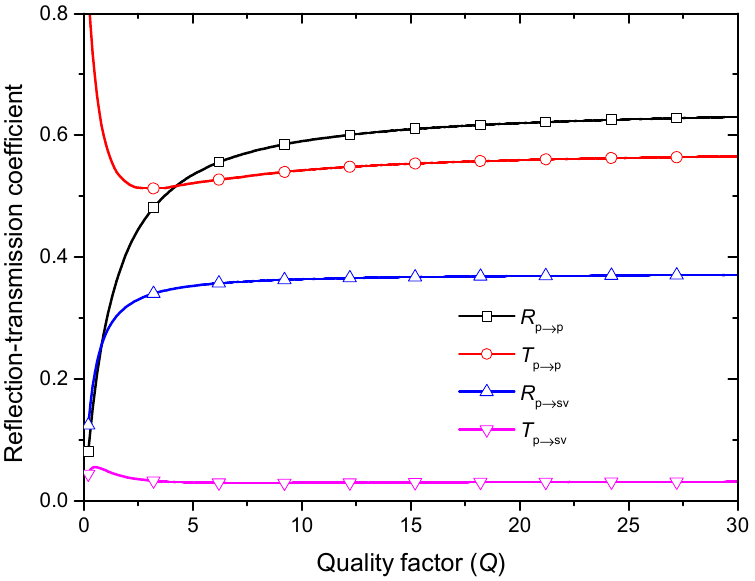
Figure 8. Reflection–transmission coefficients of a P wave impinging on a single filled joint versus the quality factor Q . The incident P wave has the frequency of 50 Hz and an incident angle of 20°.